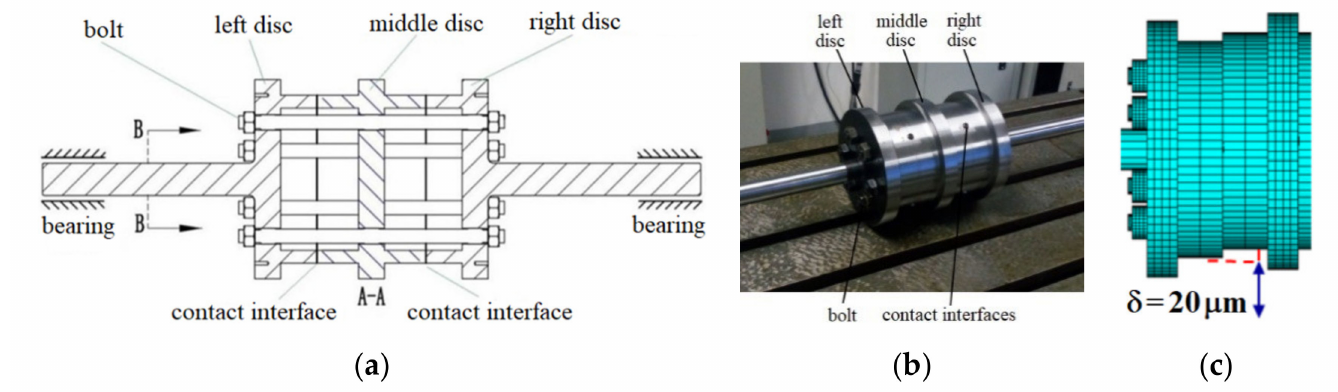
Figure 15. Rod–disk rotor structure and actual picture in the experiment and rotor’s inner misalign- ment description. ( a ) Structure diagram of the rod–disk rotor in the experiment; ( b ) Actual rotor picture; ( c ) Inner misalignment δ = 20 µ m.